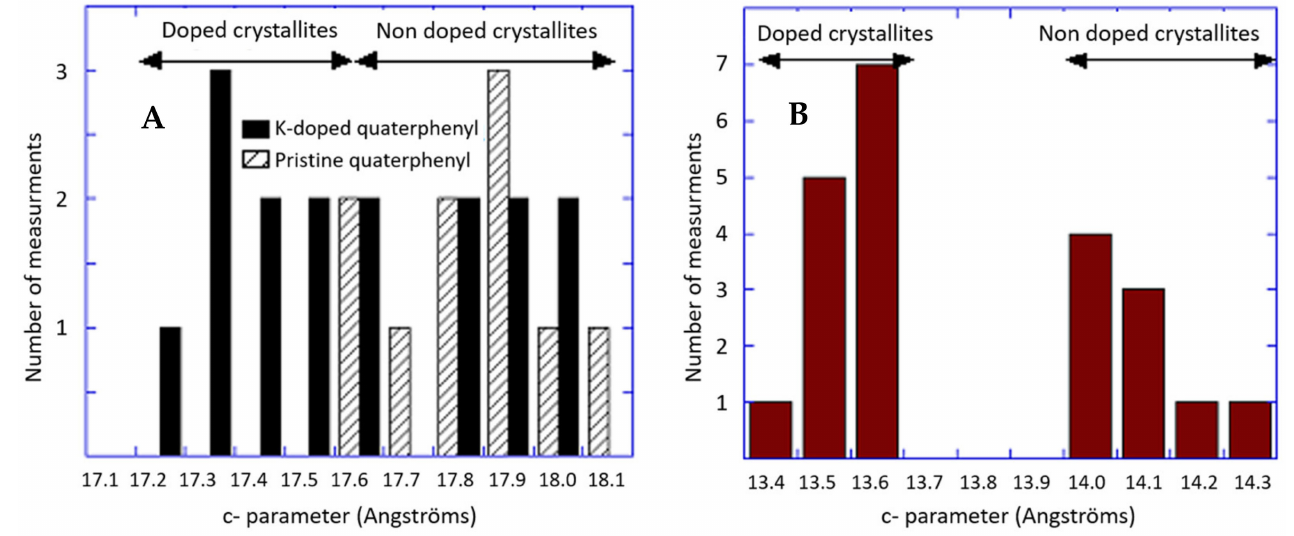
Figure 4. The comparative histograms of the pristine and K-doped quaterphenyl ( A ). Histogram of the K-doped terphenyl ( B